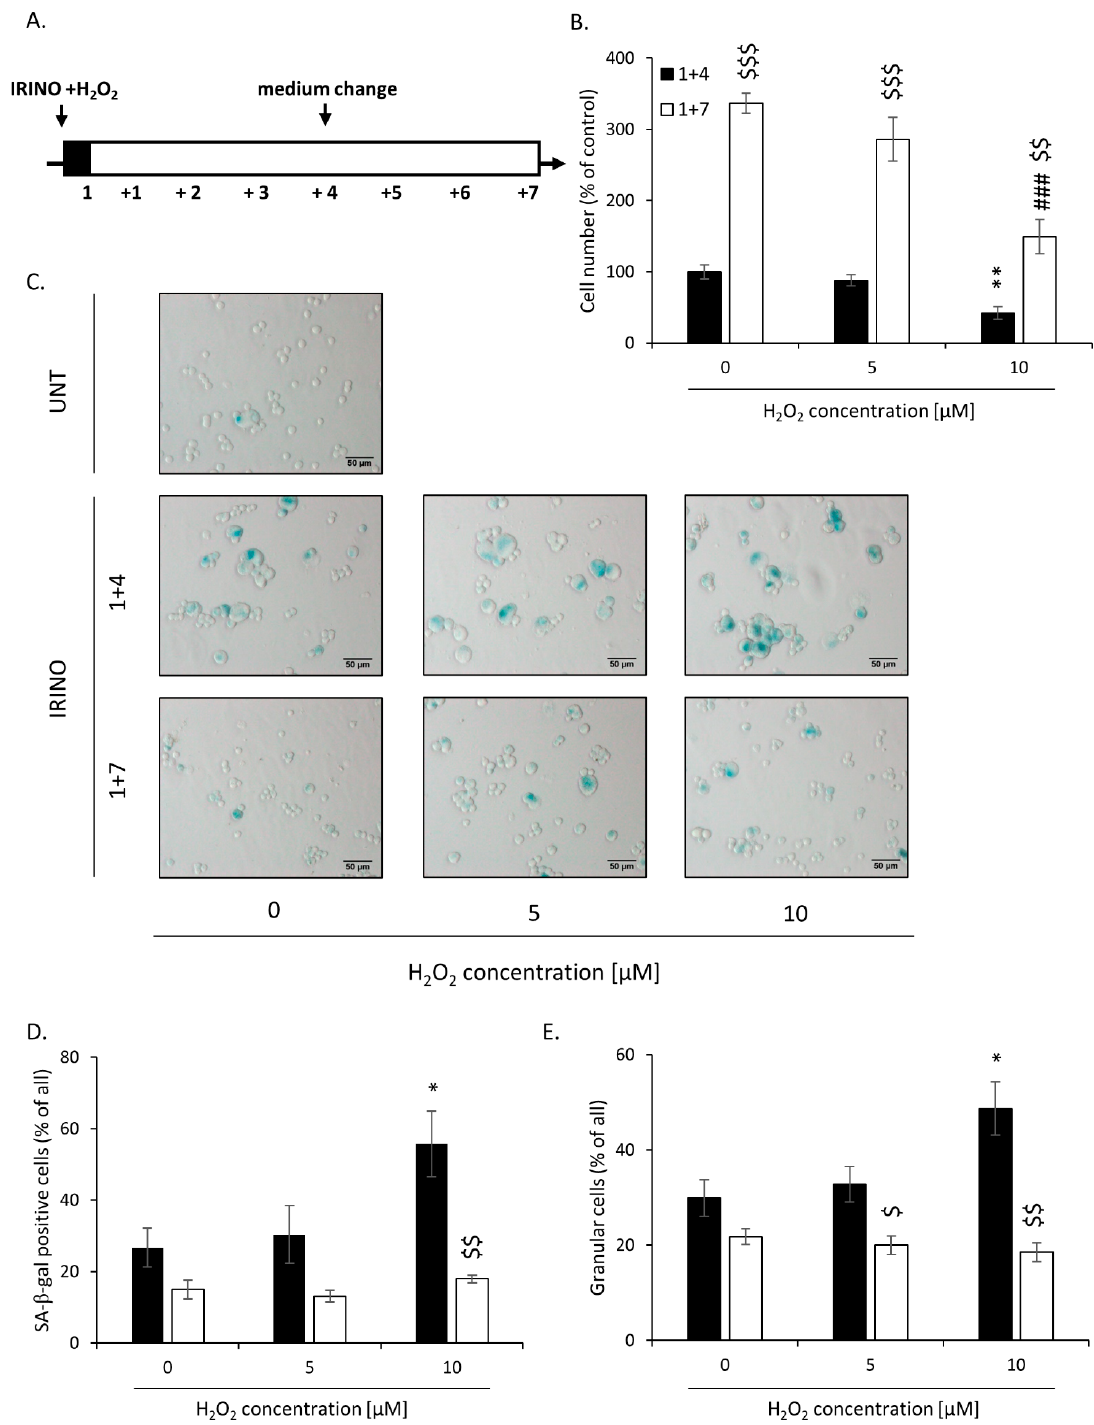
Figure 3. High H 2 O 2 leads to escape from senescence at day 1 + 7: increased cell number but decreased SA- β -Gal and granularity. ( A ) The scheme of the experiment. Cells were subjected to 2.5 µM of irinotecan and 5 or 10 µM H 2 O 2 . After 24 h, the medium was changed and the cells were cultured in a drug-free medium for 4 ( ■ ) or 7 ( □ ) days. In a 7-day long variant of the experiment, after 4 days of cell culture, the medium was changed to the new one. ( B ) Evaluation of cell number on the 4th and 7th days after the treatment. ( C ) Activity of SA- β -gal enzyme in UNT and IRINO–treated cells after treatment with H 2 O 2 . Cells were cytospined, and cytochemical staining for SA- β -gal activity was performed. Representative photos were acquired using light microscopy. Original